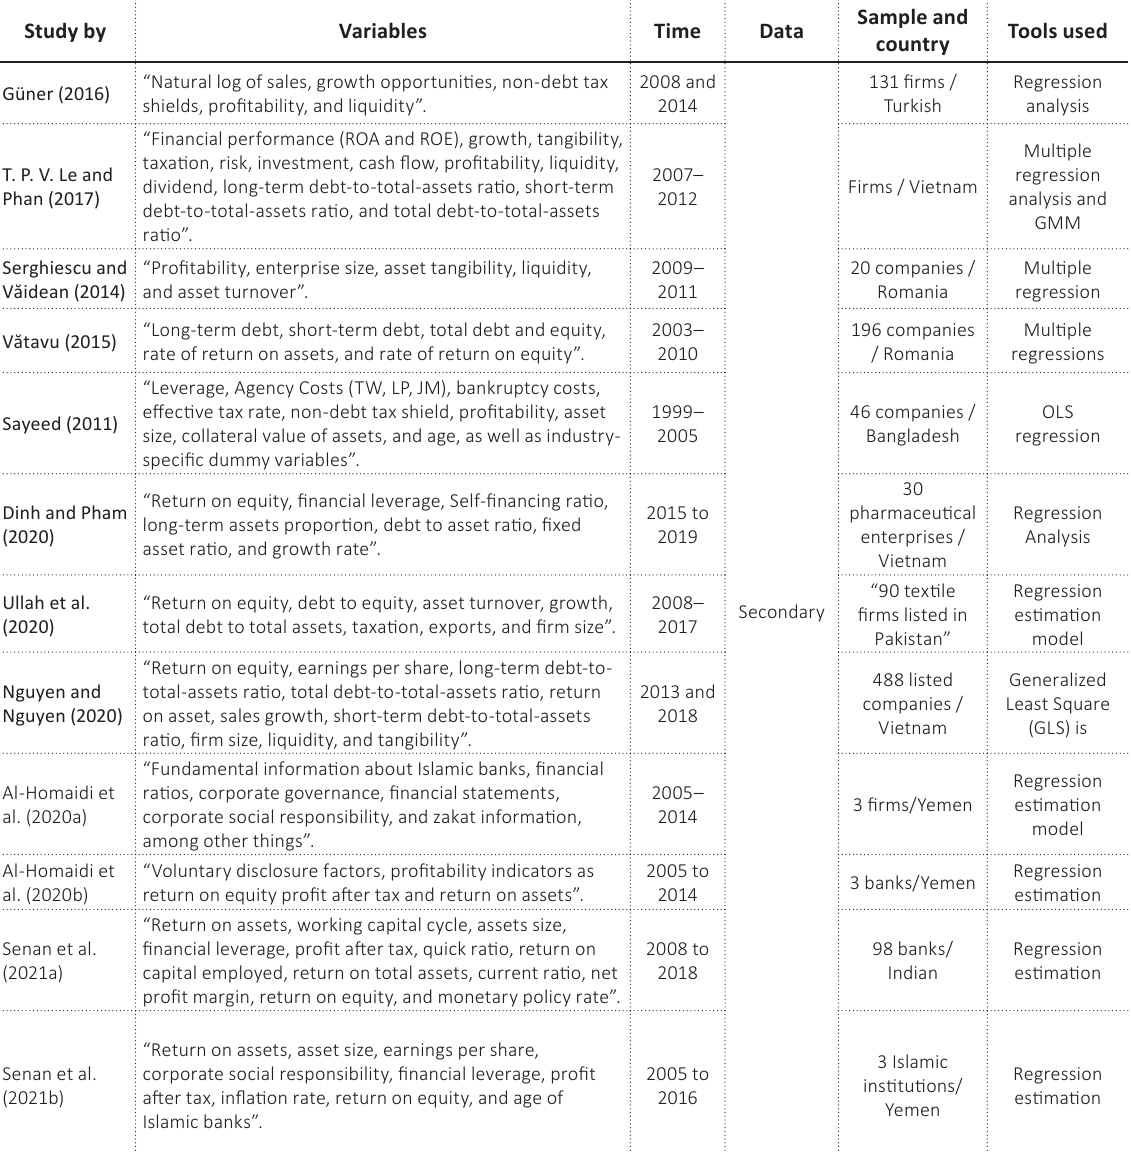
Table 1 (cont.). Empirical studies of capital structure in different